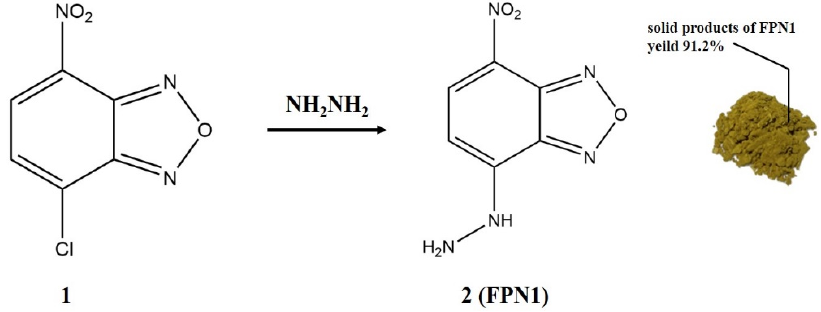
Figure 1. Synthesis scheme and morphology of FPN1.